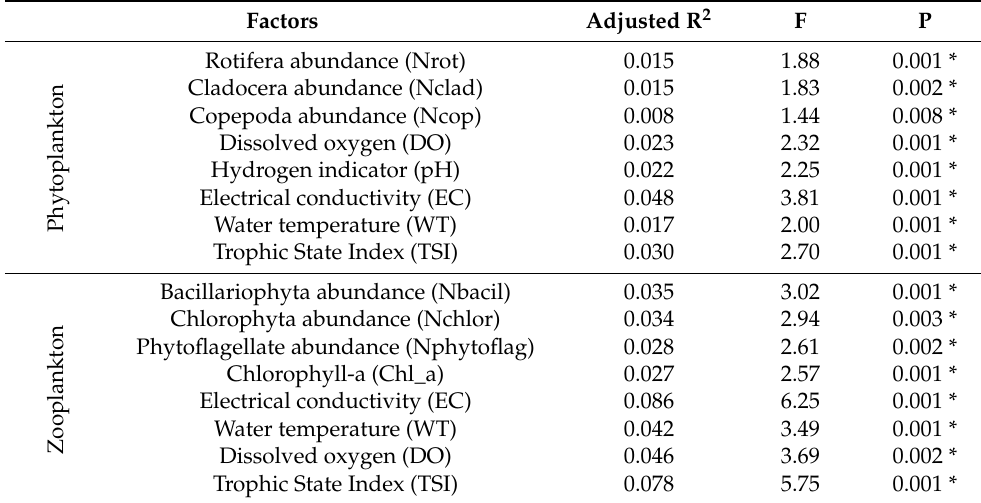
Table 4. Permutation tests results for canonical correspondence analysis (CCA) models, constructed for each variable in the Sura River and the Vetluga River mouth areas in